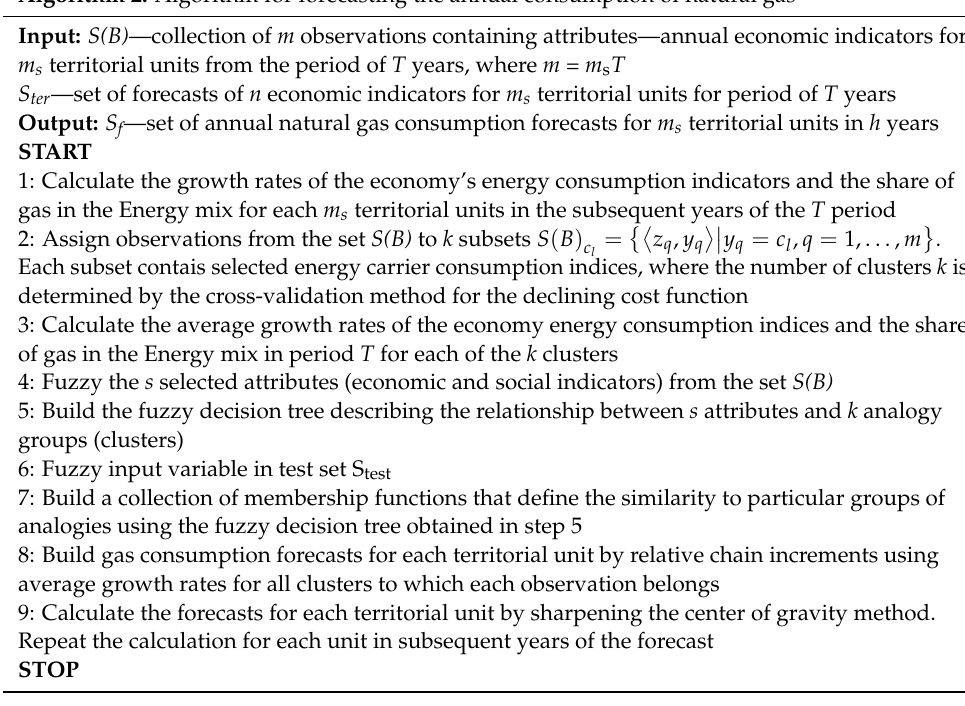
Algorithm 2. Algorithm for forecasting the annual consumption of natural